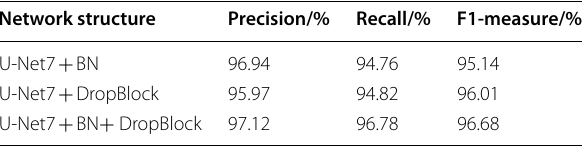
Table 5 Massachusetts dataset for comparing network models’ and experimentation outcomes Network structure